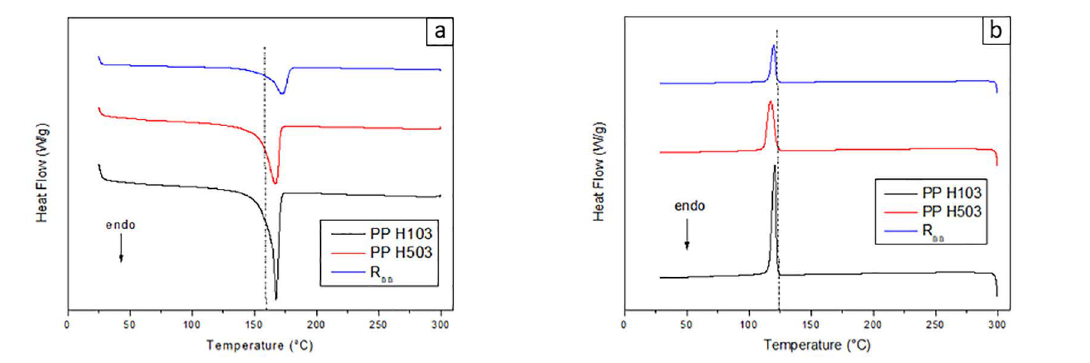
acquired during heating (a) and cooling (b) at BB